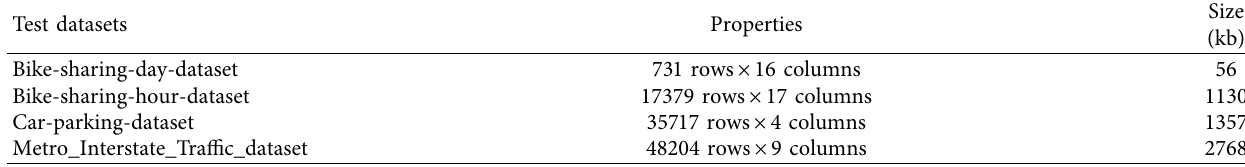
Table 6: The experimental datasets for conversion performance test.